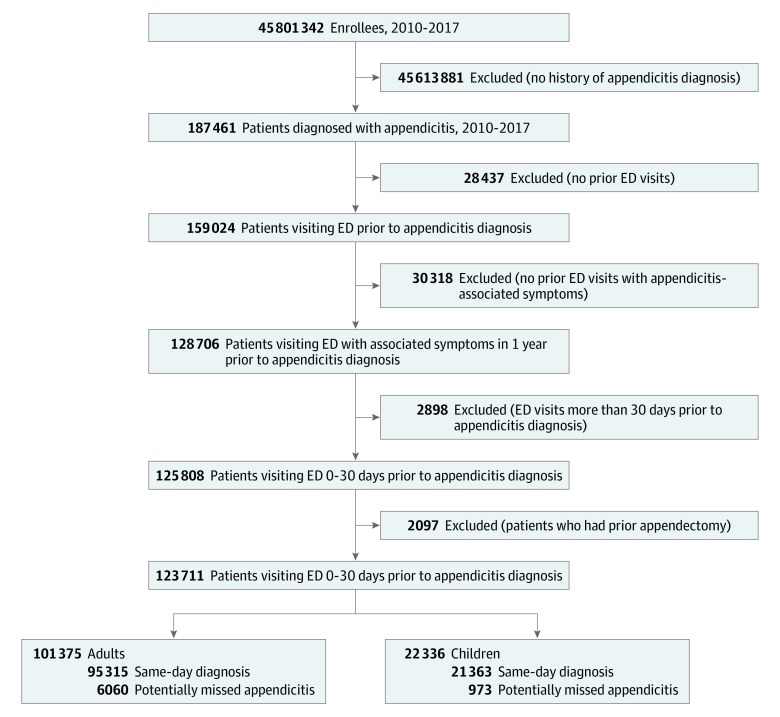
Flow Diagram of Study Population SelectionED indicates emergency department.